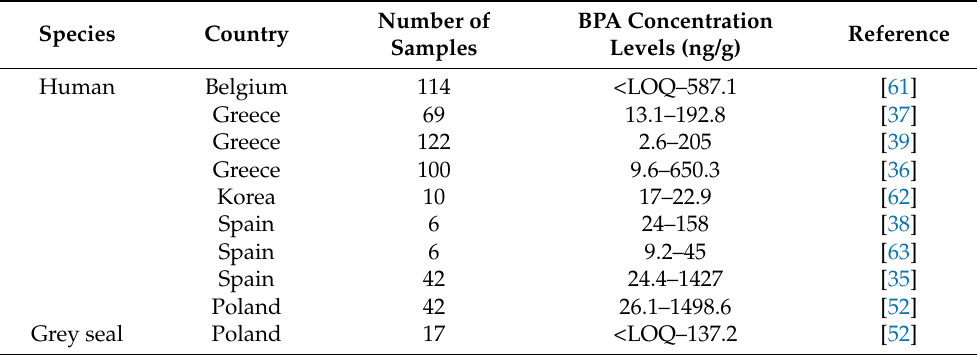
Table 3. Biomonitoring studies of BPA in the